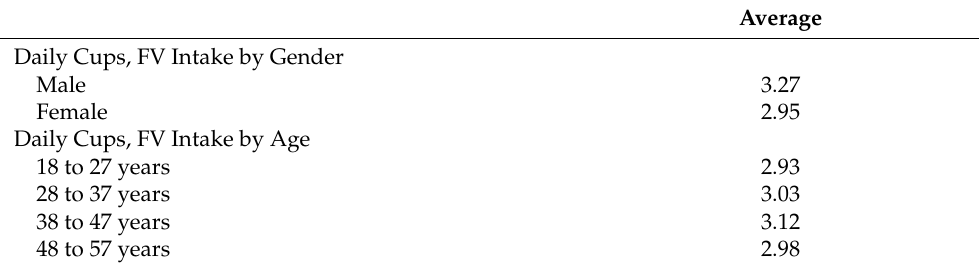
Table 2. Mean baseline FV intake and